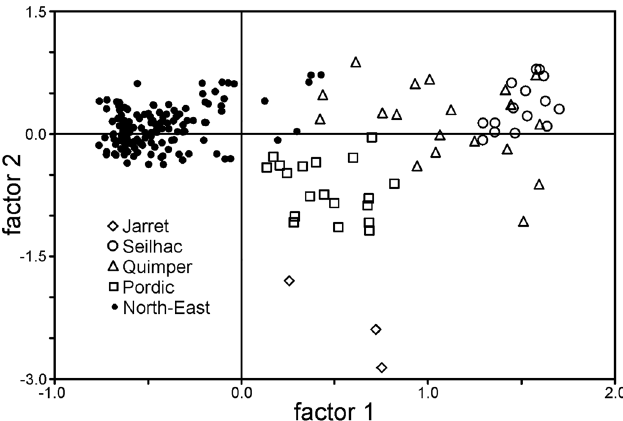
Fig 3. Bi-dimensional representation of individual genotypes provided by the factorial correspondence analysis. Each allele is used as an independent variable, with no a priori assumptions about grouping. Individuals of North-Eastern populations are represented by the same symbol as they intermix in the